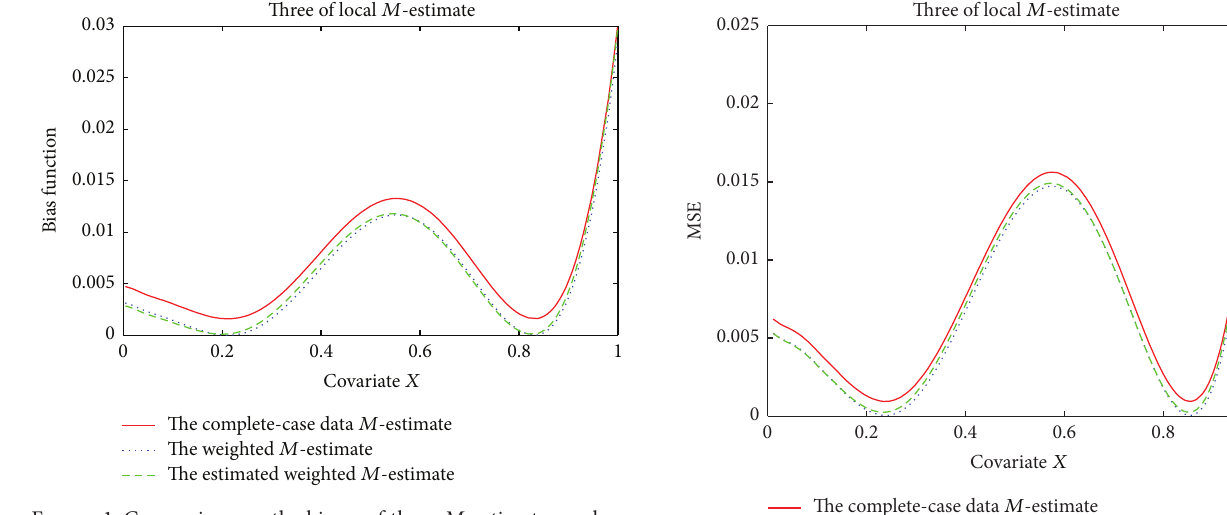
Figure 1: Comparison on the biases of three 𝑀 -estimators, where thesolidcurve,thedashedcurve,andthedotcurvedenotethebiases of ̂𝑚 𝑀𝑐𝑐 (𝑥) , ̂𝑚 ∗ 𝑀 (𝑥) , and ̂𝑚 ∗ 𝑀𝑐𝑝 (𝑥) , respectively.